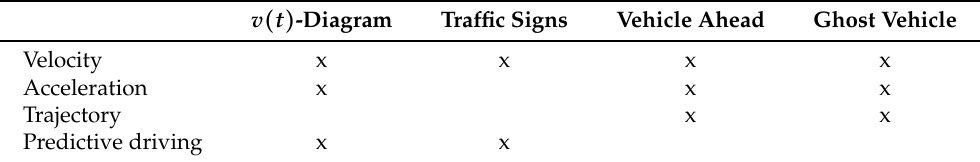
Table 1. Possible options for the visualization of target values for the human driver. v ( t ) -Diagram Traffic